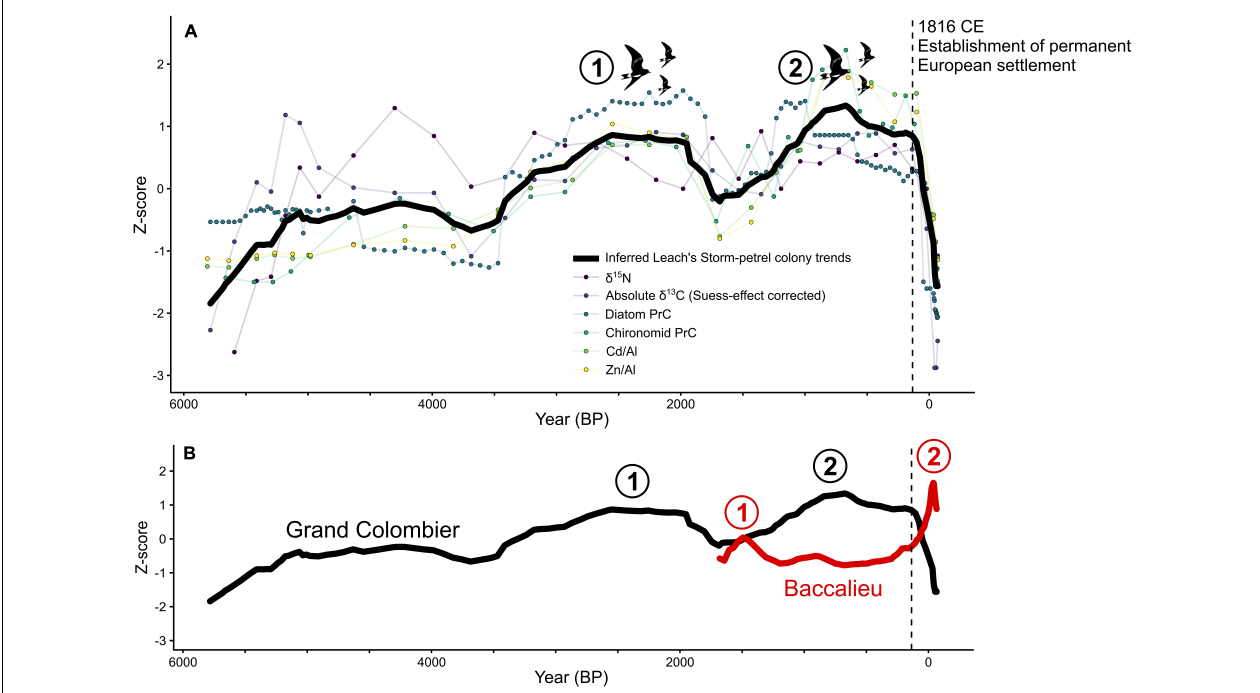
FIGURE 4 | Long-term population trends of Leach’s storm-petrel colony dynamics from Grand Colombier Island and Baccalieu Island from the Northwest Atlantic Ocean (Duda et al., 2020a). (A) Overall trends in the Grand Colombier Island Leach’s storm-petrel population as determined by the mean of all measured paleolimnological proxies. (B) Trends of Grand Colombier Island contrasted to ∼ 1,700 years of population trends on Baccalieu Island, as detailed in Duda et al. (2020c). The distinct peaks in the storm-petrel colony size are identified numerically. Note that the rapid population decline is concurrent with the European population expansion in the St. Pierre and Miquelon archipelago, beginning in 1816 CE.